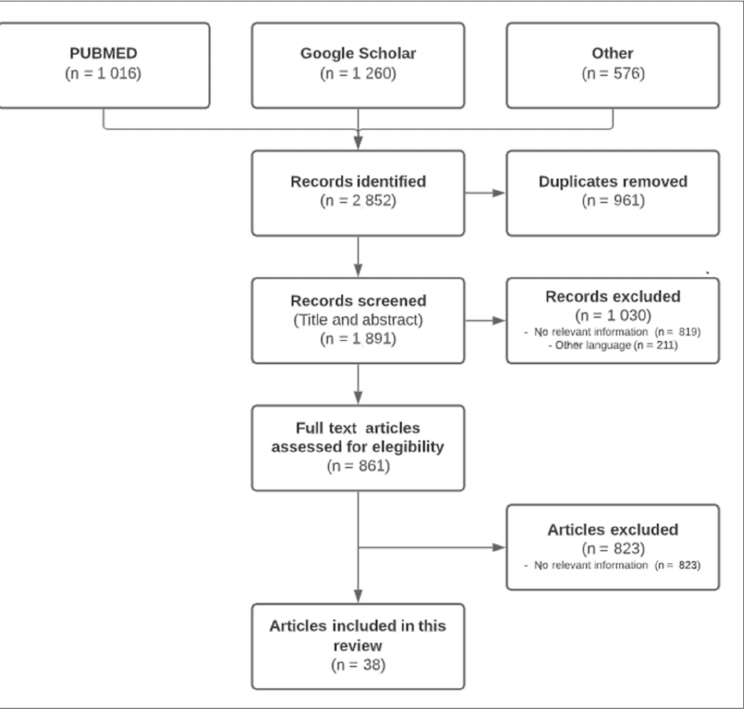
Figure 2. Flow diagram of the study selection